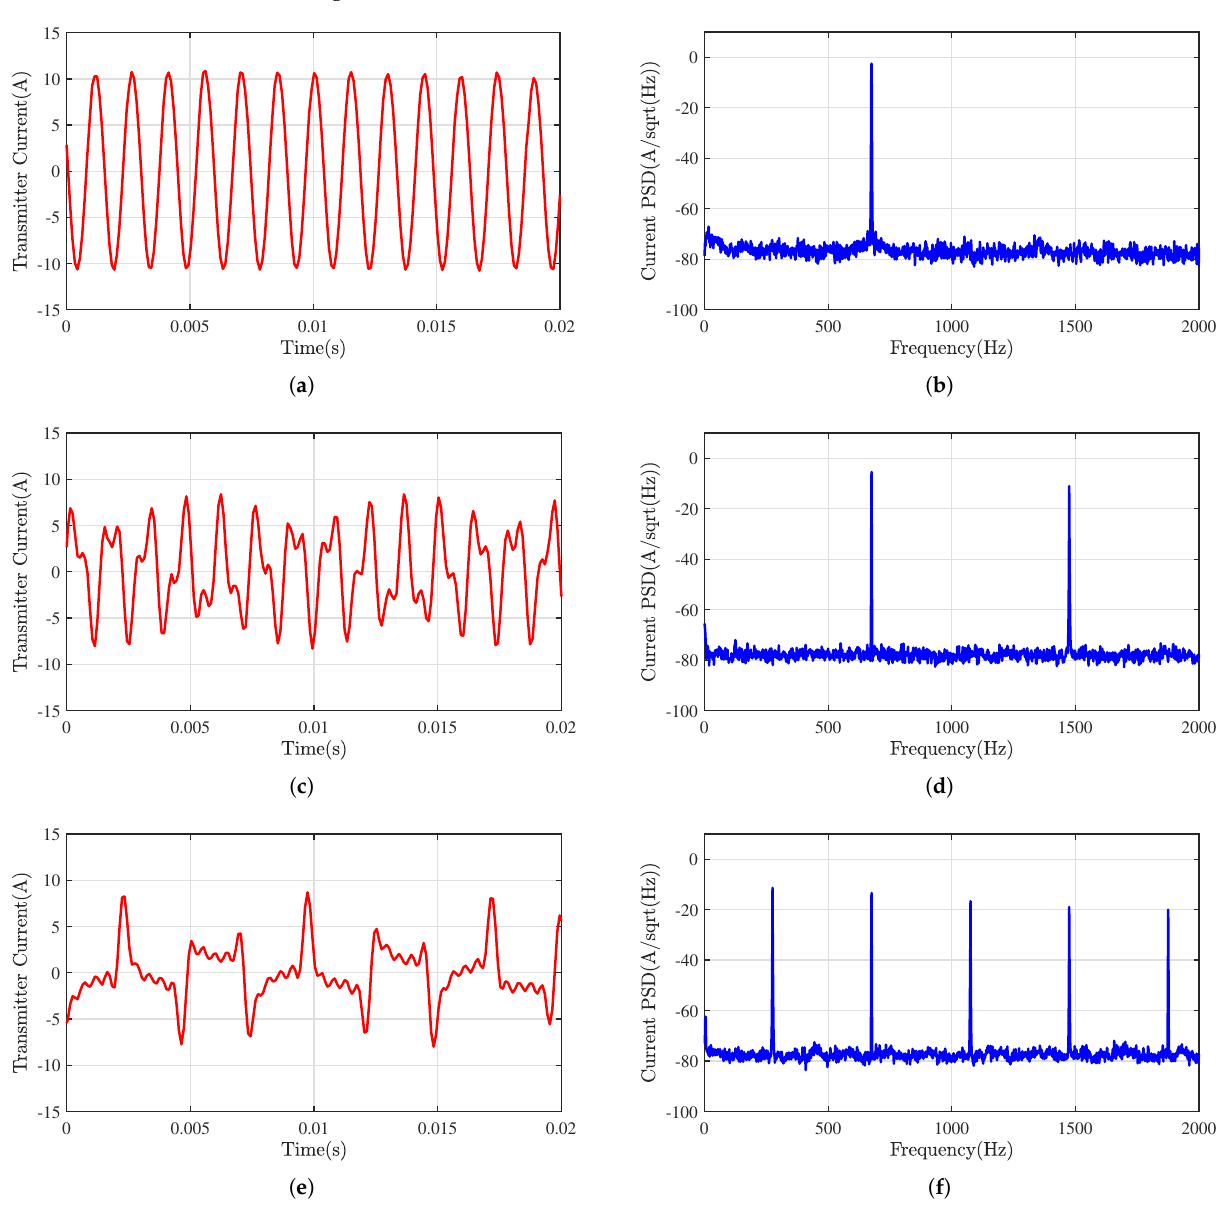
Figure 8. Test results for transmitting module. ( a ) Single-frequency transmitting waveform; ( b ) power spectral density of single-frequency waveform; ( c ) double-frequency transmitting wave- form; ( d ) power spectral density of double-frequency waveform; ( e ) five-frequency transmitting waveform; ( f ) power spectral density of five-frequency